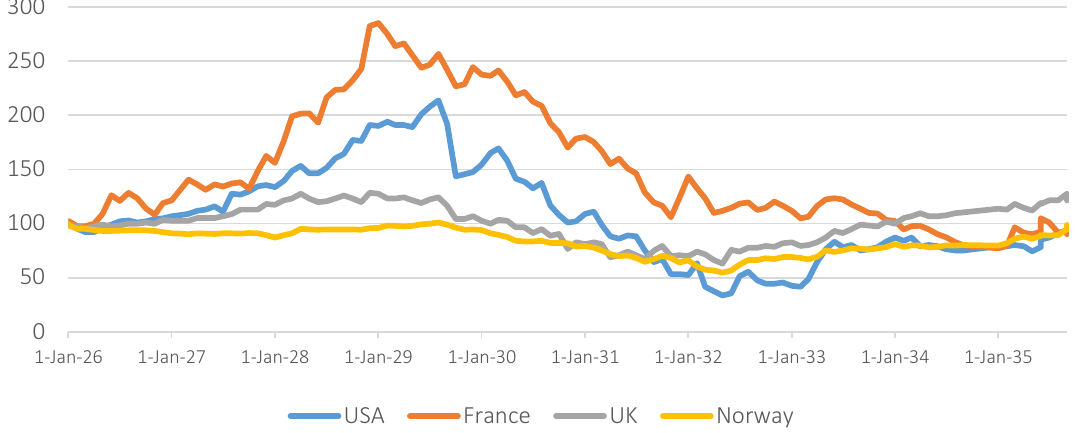
Figure 5. Stock market indices Jan-1926 – Sept-1935 (Jan-1926 =